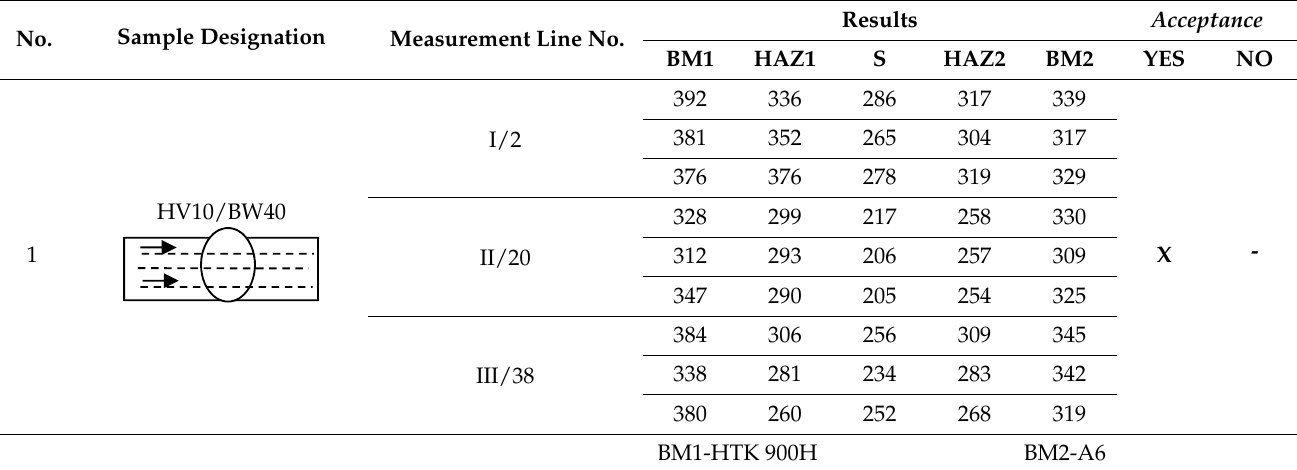
Table 5. Results of hardness distribution for HTK 900H + A6 casting welded joint.